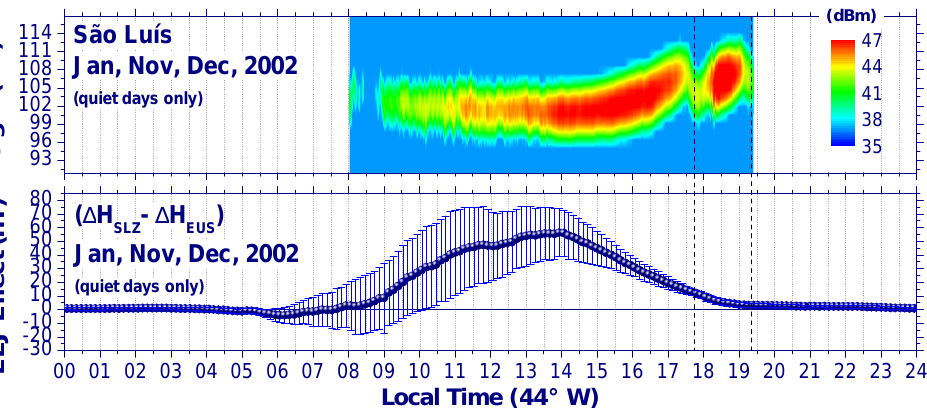
Fig. 1. Upper panel: mean RTI map obtained for the quiet period ( K p ≤ 3+) using the RESCO radar during the Southern Hemisphere summer solstice. The colour scale gives the signal power. Bottom panel: Mean diurnal variation of the 1 H= 1 H SLZ – 1 H EUS for the same period of upper mean RTI map, representing the EEJ ground effect (strength), deduced from variations of the H component of the Earth’s magnetic field measured by magnetometers in São Luís and Eusébio, respectively.